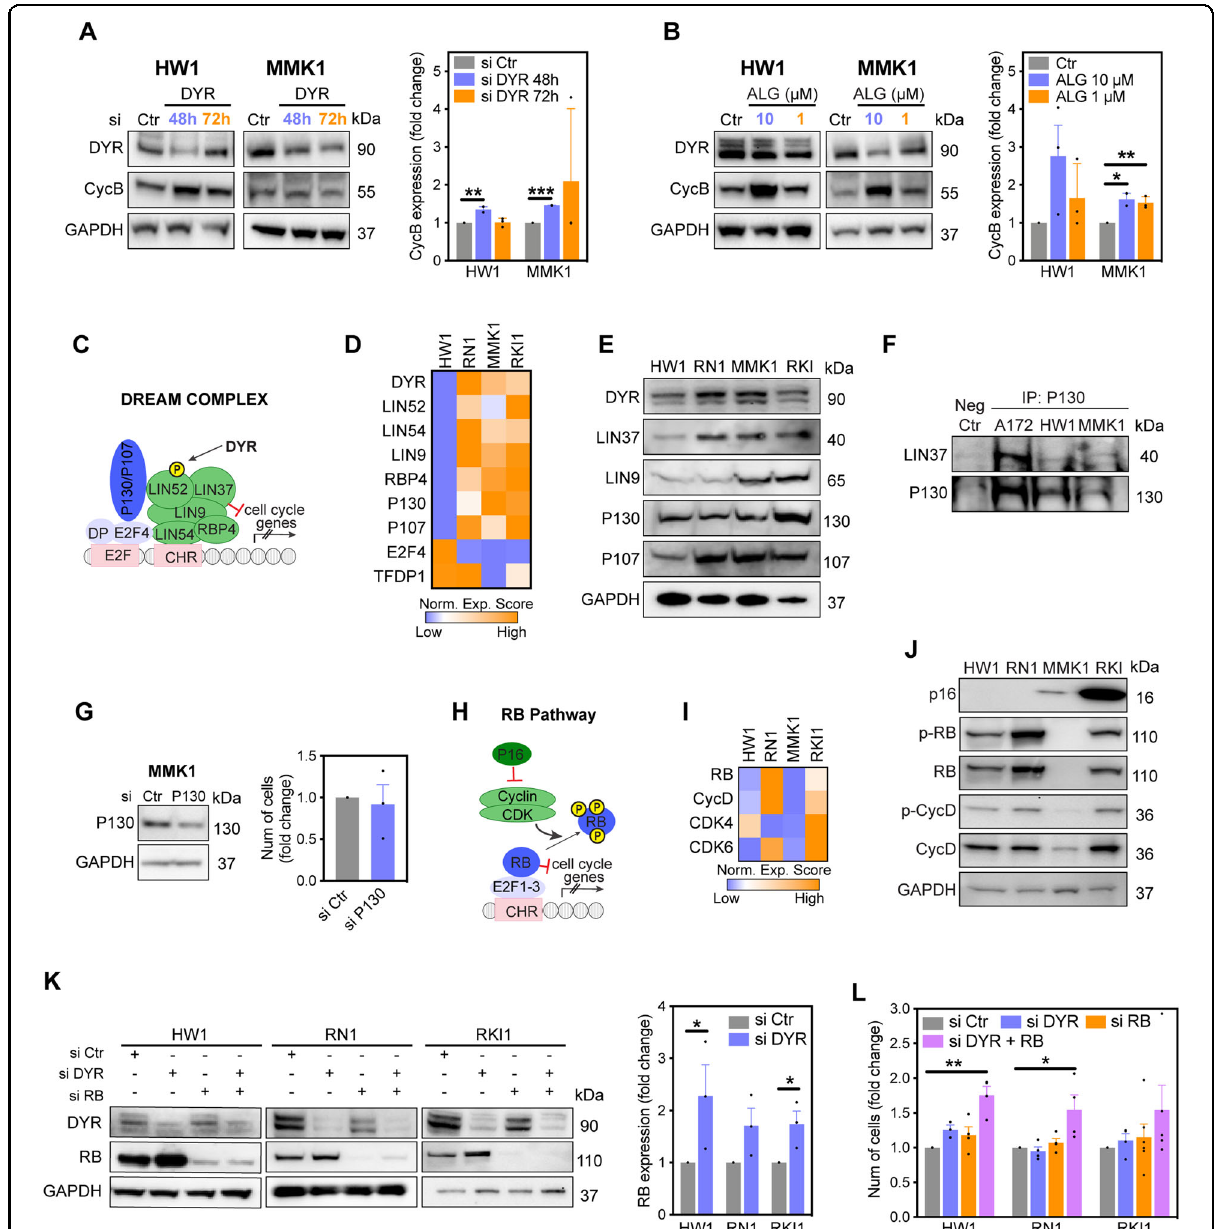
Fig. 6 Retinoblastoma expression determines the proliferative response to DYRK1A inhibition. A, B Immunoblot analysis and densitometric quanti fi cation of cyclin B (CycB) expression in cells treated with scramble (si Ctr) and DYRK1A (si DYR) targeting siRNA (72 h), and in cells treated with DYRK1A inhibitor ALGERNON (ALG, 72 h). C Schematic overview of DREAM complex. RNA seq data showing gene expression ( D ) and immunoblot analysis showing protein expression ( E ) of DREAM complex components in glioblastoma stem cells. F Immunoblot analysis of DREAM complex assembly in glioblastoma cells. Cell lysates were fi rst immunoprecipitated (IP) with an anti-P130 antibody, then immunoblotted against P130 and LIN37. G Immunoblot analysis of MMK1 cells transfected with P130-targeting siRNA (si P130) for 72 h and nuclear staining quanti fi cation of cells transfected with si P130 for 7 days. H Schematic overview of retinoblastoma (RB) pathway. RNA seq data ( I ) and immunoblot analysis ( J ) of RB pathway components in glioblastoma stem cells. K , M Immunoblots analysis of cells transfected with scramble (si Ctr), DYRK1A-targeting (si DYR) and RB-targeting (si RB) siRNA for 72 h. Densitometric quanti fi cation of RB expression following DYRK1A knockdown is shown. L Nuclear staining quanti fi cation of cells single transfected with si DYR or si RB, and double transfected (si DYR + RB) for 7 days. All bar graphs represent mean ± SEM from at least three independent experiments (two-tailed unpaired t -test, * P < 0.05, ** P < 0.01, *** P < 0.001).